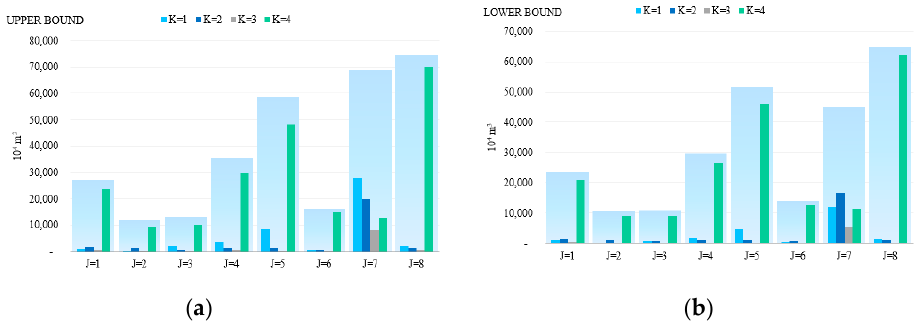
Figure 9. Optimal scheme of water resources distribution in the Yinma River Basin in the second planning period. ( a ) Upper bound of water resources; ( b ) Lower bound of water resources.